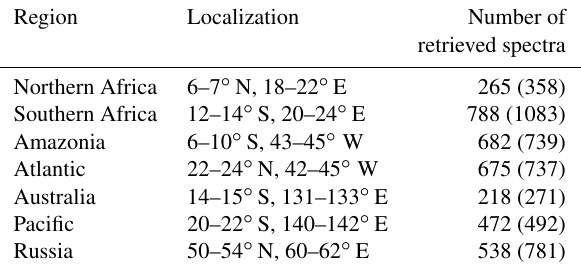
Table 1. Selected regions used for the retrieval. The localization of each area and the number of spectra retrieved during the studied period are provided. The numbers correspond to the total number of successfully retrieved spectra and those given in parentheses to the total number of spectra in each region.